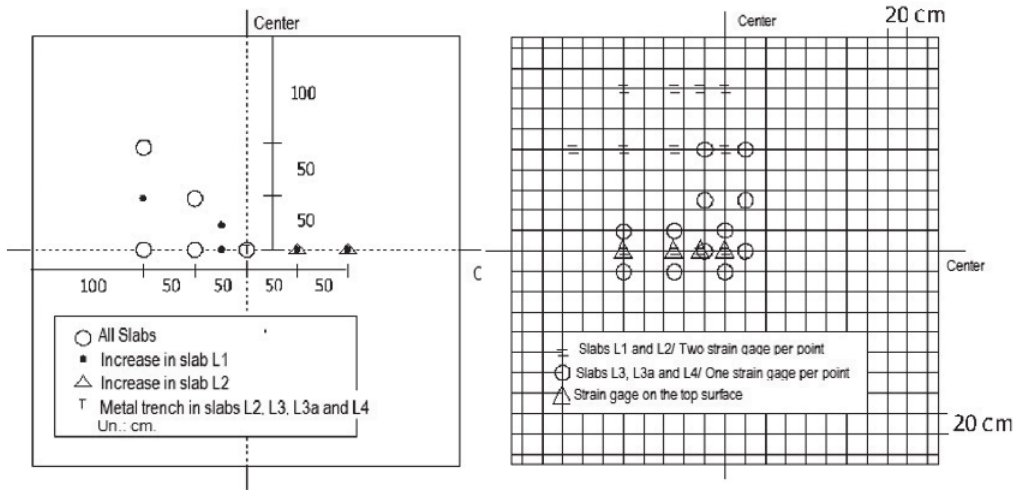
Position of the deflectometers and electrical strain gages fixed in the flexural reinforcement and on the concrete surface of the slabs